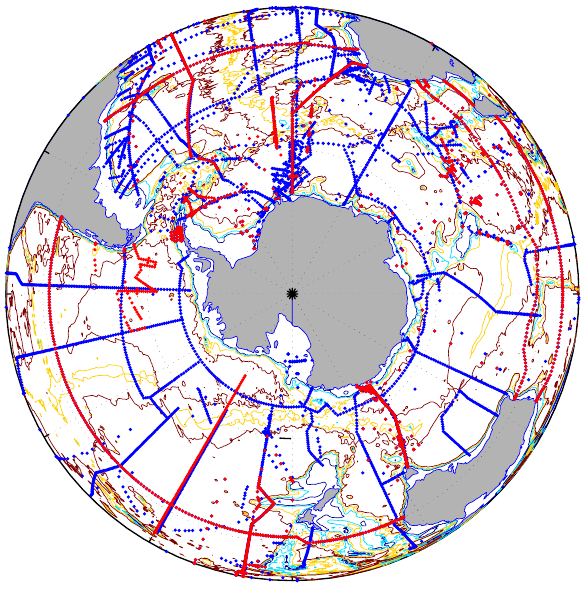
Figure 1. Map of the Southern Ocean with CARINA station posi- tions in red and GLODAP reference cruise stations in blue.